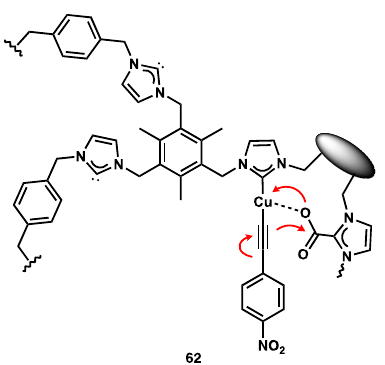
Figure 6. Cooperative CO 2 insertion into the C–H bond of terminal alkynes by copper(I) and a free carbene on a poly-NHC scaffold 62 .